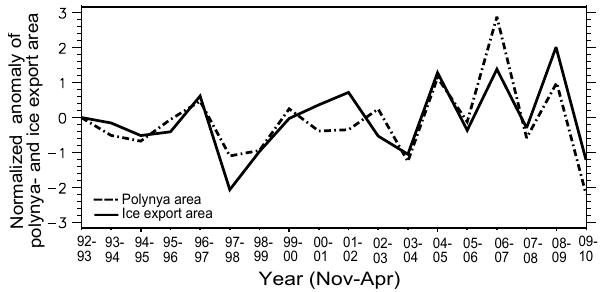
Fig. 12. Normalized anomalies of accumulated polynya area (thin ice and open water, dashed dotted line) and total ice area flux (solid line) between November and April from 1992 until 2009.